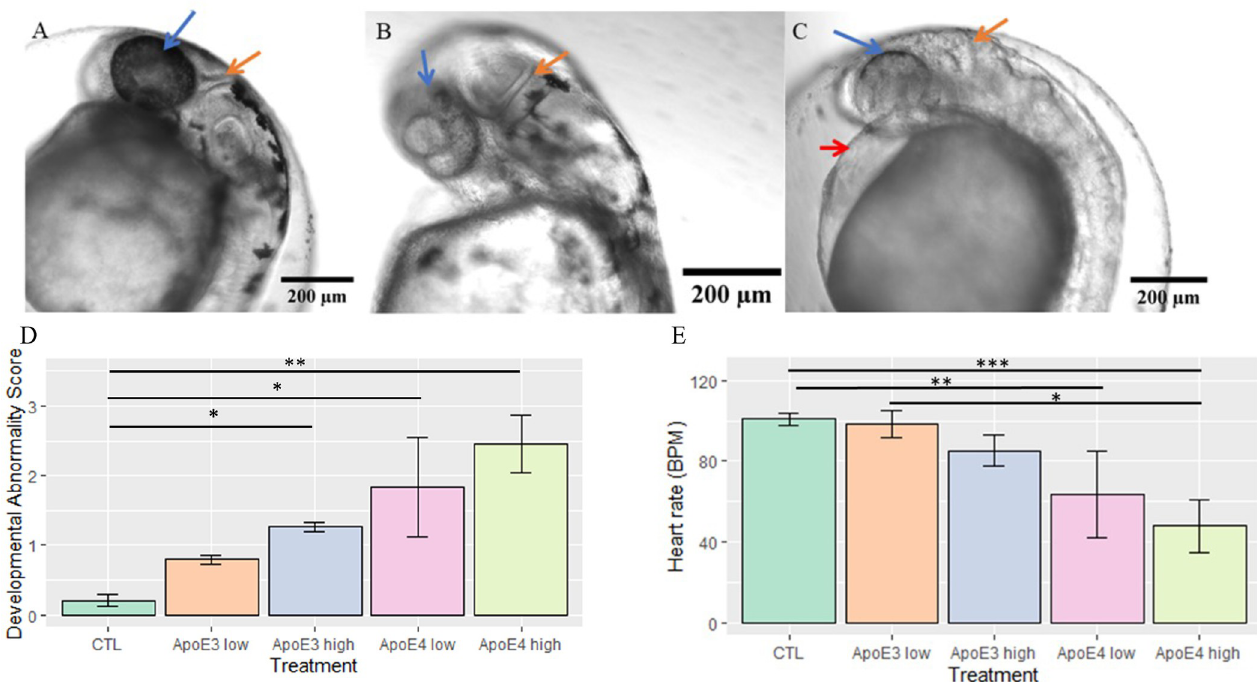
Fig 2. A sublethal concentration of nApoE4 1-151 leads to morphological abnormalities in zebrafish embryos at the hatching phase. Representative light phase contrast microscopic images following live imaging of embryos at 48 hpf following a 24-hour period with respective treatments (Control, 25 μ g/ml of nApoE3 1-151 , or 25 μ g/ml of nApoE4 1-151 . A: Arrows point to consistent morphological changes as compared to untreated controls that are healthy and categorized as having a developmental abnormality score of < 1.0 (Panel A). The blue arrows designate pigmentation changes; orange arrows designate cerebellar primordium junction differences in the hindbrain. B: Exogenous treatment with nApoE3 1-151 impacted pigmentation pattern in otherwise healthy embryos. Embryos in this category were most likely to receive a score of < 1. C: 24-hour incubation of a sublethal concentration of nApoE4 1-151 resulted in developmental abnormality scores > 3. Embryos in this category were typically observed to be delayed in development with limited hindbrain folding (orange arrow), limited or lacking pigmentation (blue arrow), as well as enlargement of the cardiac cavity (red arrow). D. Quantitative developmental abnormality scores for each treatment group following treatment of embryos for 24 hours with respective fragments at low E3 (orange bar), E4 (pink bar) concentrations (25 μ g/ml) or at high concentrations (50 μ g/ml) E3 (gray bar), E4 (yellow bar). The nApoE4 1-151 25 μ g/ml-treated groups were significantly different from controls (H(4) = -2.43, p = 0.0074). At 50 μ g/ml both nApoE4 1-151 (H(4) = -3.32, p = 0.0004) and nApoE3 1-151 -treatment groups (H(4) = -1.77, p = 0.037) were significantly different from controls. Errors bars represent ± S.E.M. � p < 0.05, �� p < 0.01, ��� p < 0.001 E. Heart rate data obtained from live microscope analyses in 25 μ g/ml and 50 μ g/ml treatment groups nApoE3 1-151 and nApoE4 1-151 compared to non-treated controls. nApoE4 1-151 (pink bar, 25 μ g/ml) was significantly different from controls (H(4) = 1.77, p = 0.038). nApoE4 1-151 (yellow bar, 50 μ g/ml) was significantly different from nApoE3 1-151 25 μ g/ml (H(4) = 1.94, p = 0.026) and controls (H(4) = 2.665, p = 0.0036). Errors bars represent ± S.E.M. All other comparisons were insignificant. � p < 0.05, �� p < 0.01, ��� p <